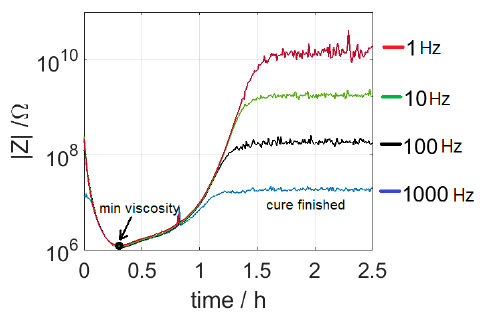
Figure 2. Measuring the changes of impedance by a screen-printed IDC